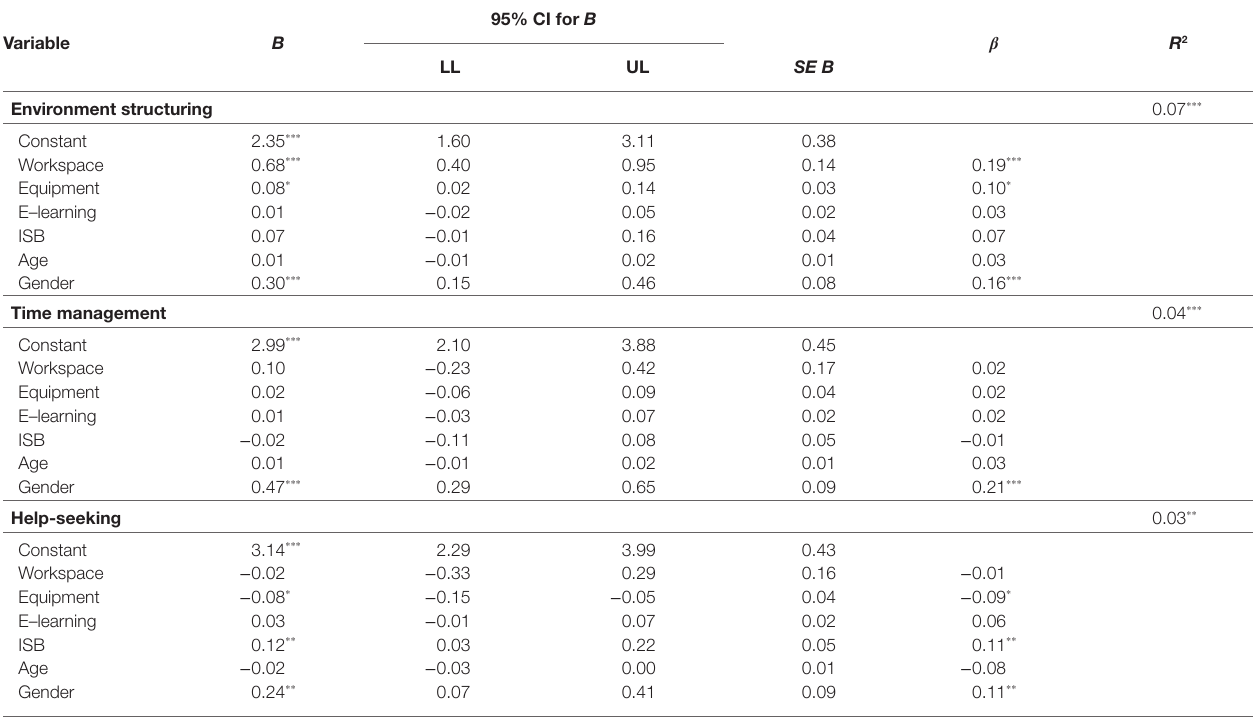
TABLE 4 | Separate regression analyses to predict strategy use during the term based on students’ digital readiness.